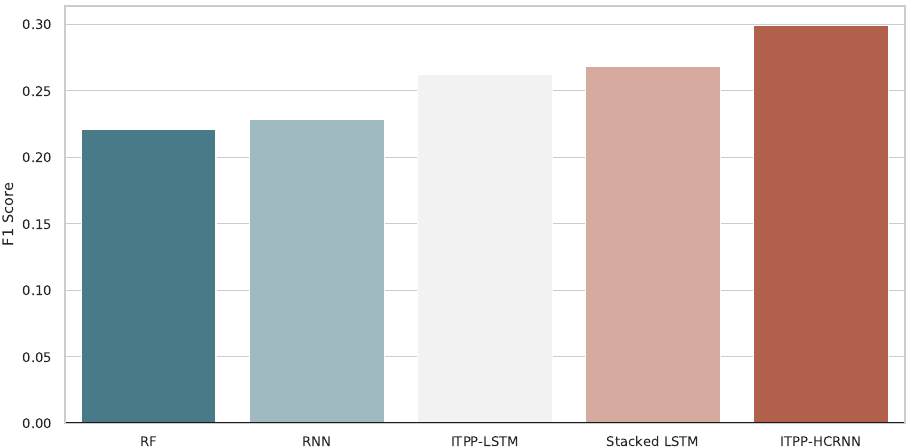
Figure 6. The F1 score results for different models. RF: random forest; RNN: recurrent neural network; ITPP: important trading point prediction; LSTM: long short-term memory; HCRNN: hybrid convolutional recurrent neural